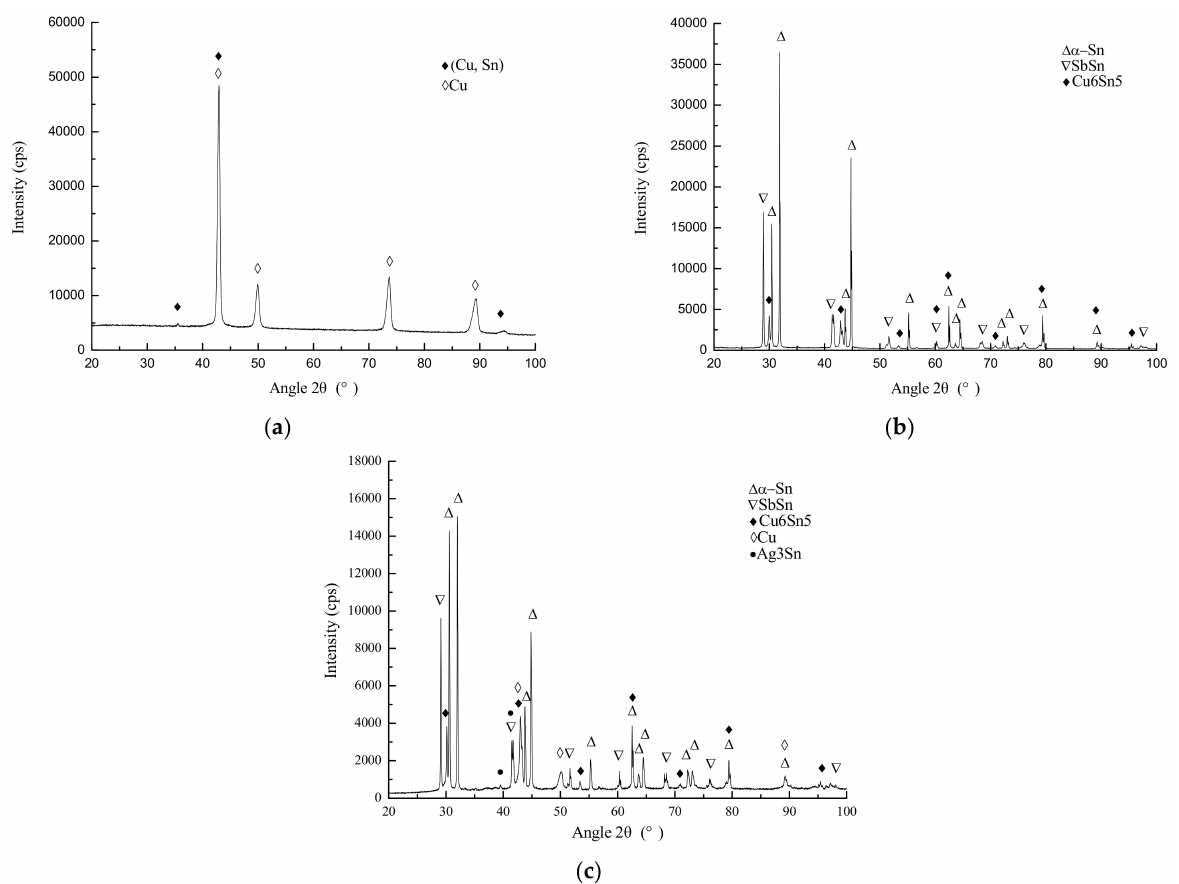
Figure 3. The X-ray diffraction patterns: ( a ) the substrate; ( b ) Babbitt B83; ( c ) the running-in coatings of specimen